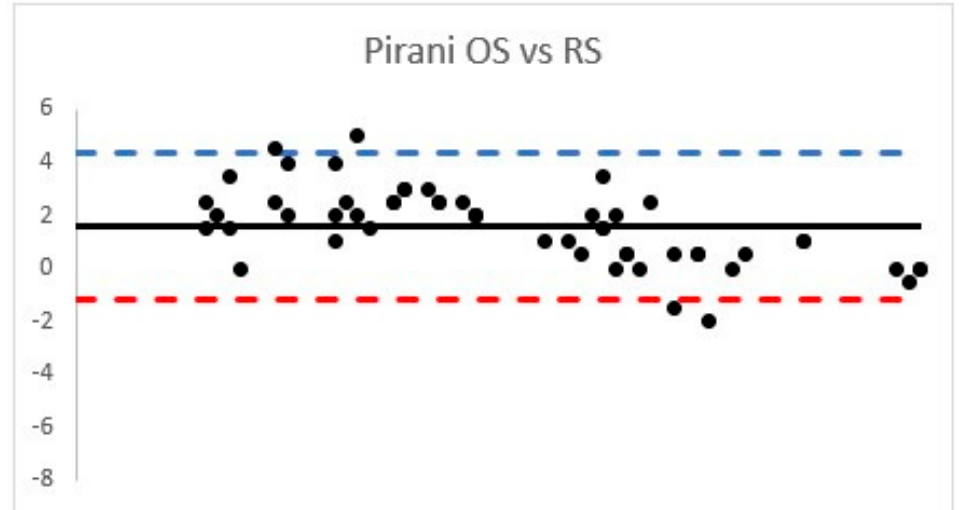
Figure 1. Bland Altman plots according to OS and RS Pirani score. (95% confidence interval 0.68–0.86); RS ICC = 0.80 (95% confidence interval 0.70–0.87)) (Figure 2).